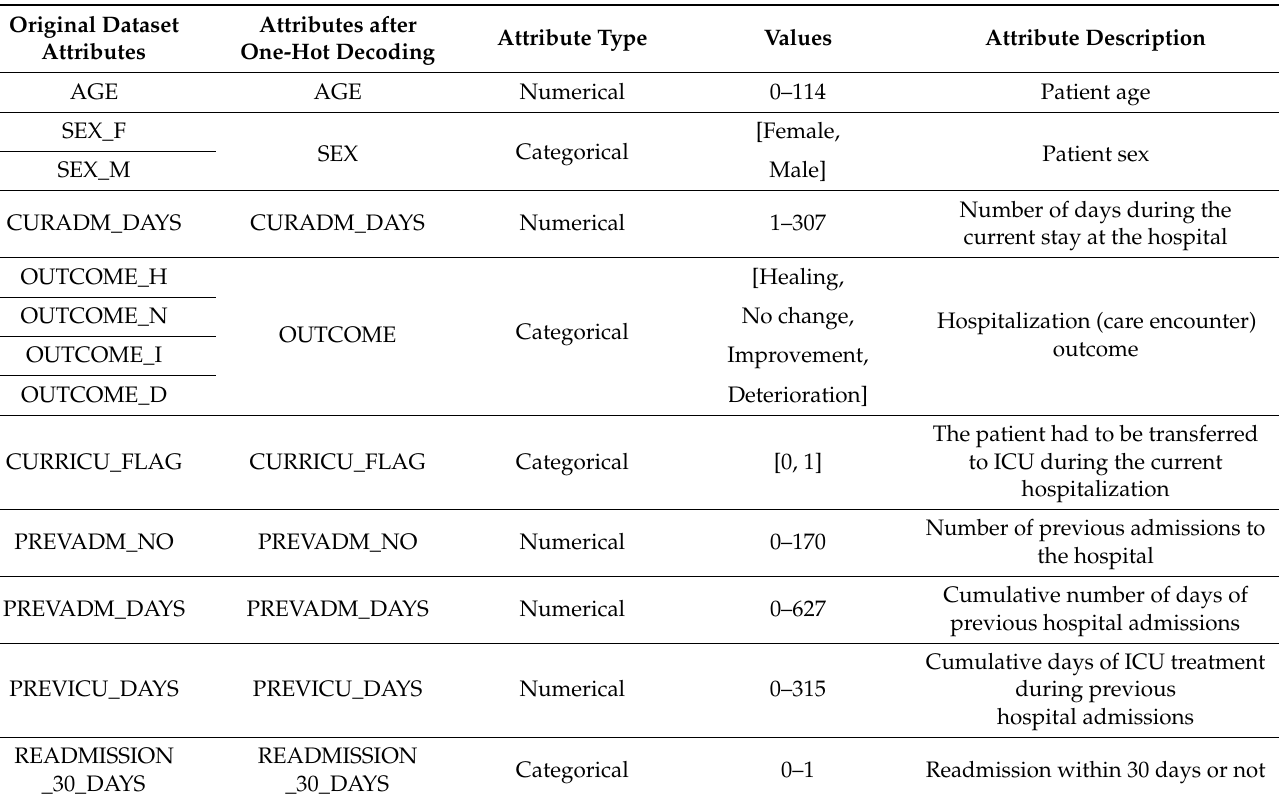
Table 1. The attributes of the original dataset, the attributes after the one-hot decoding and their